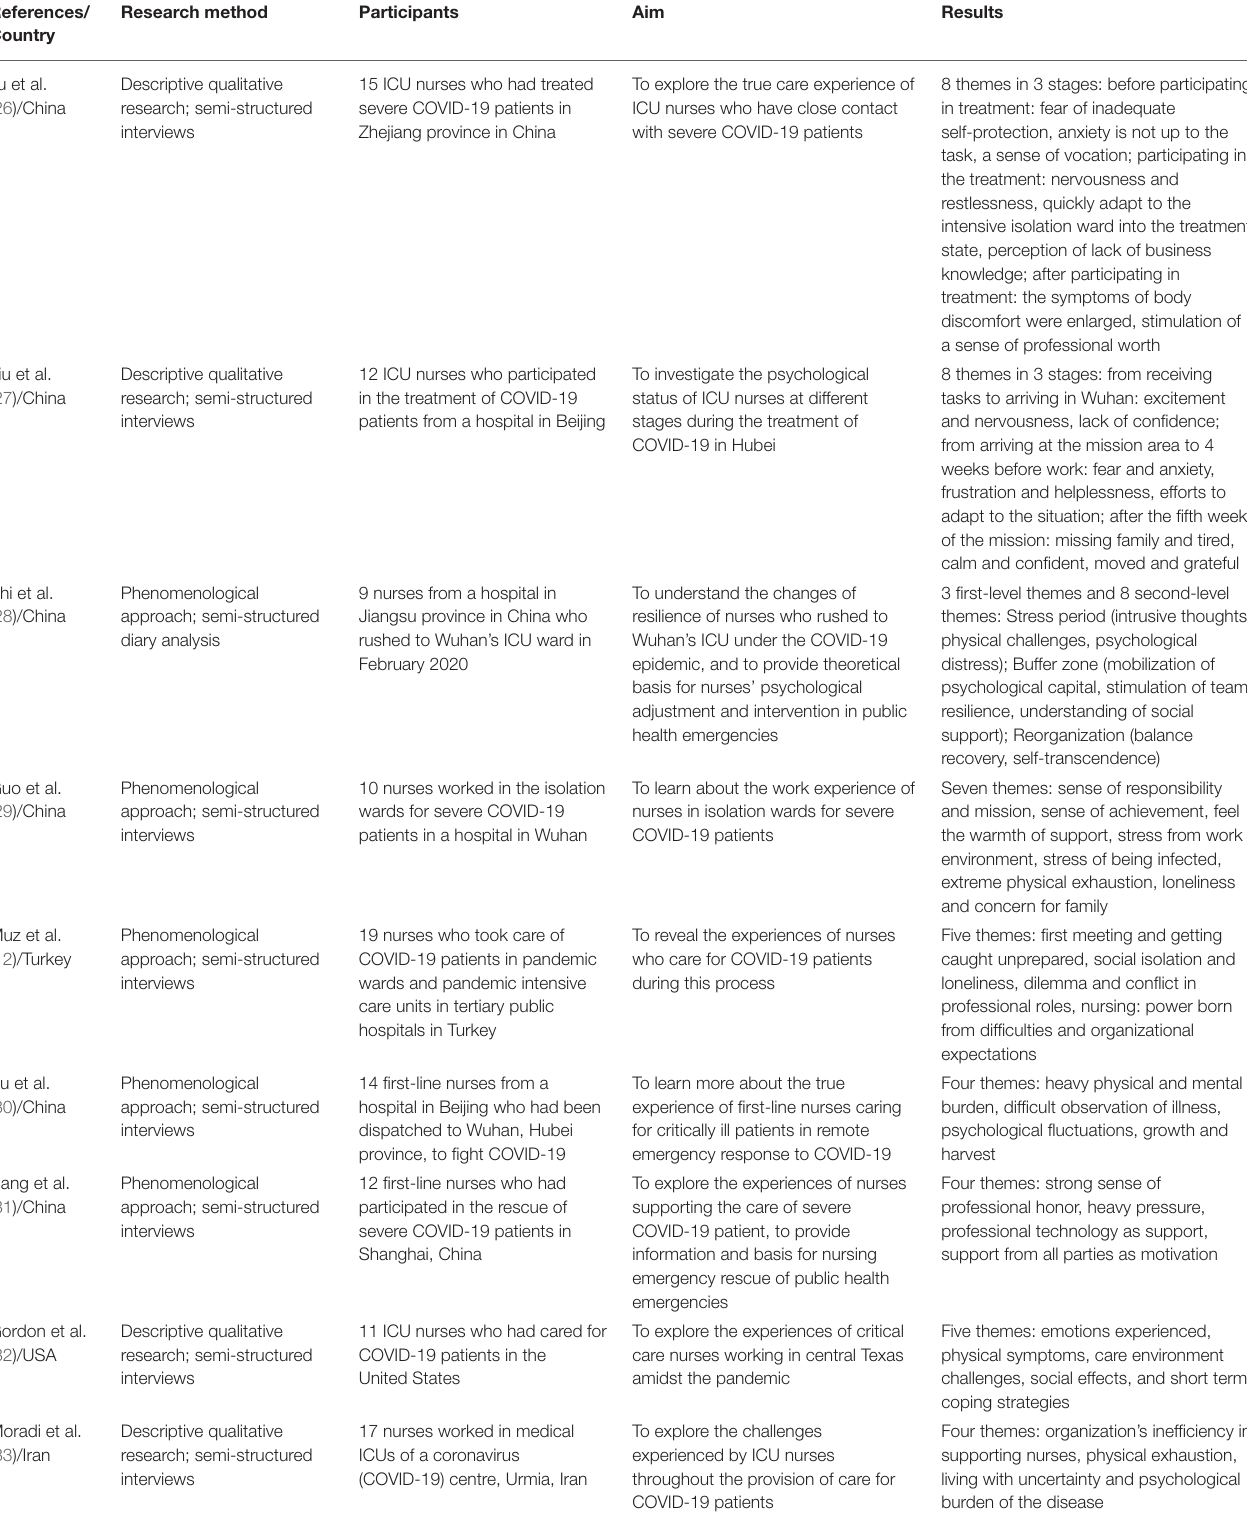
TABLE 2 | Description of the included